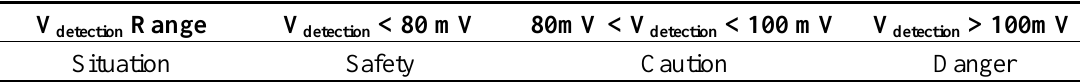
Table 1. The vibration sensor detects the voltage range corresponding to the actual